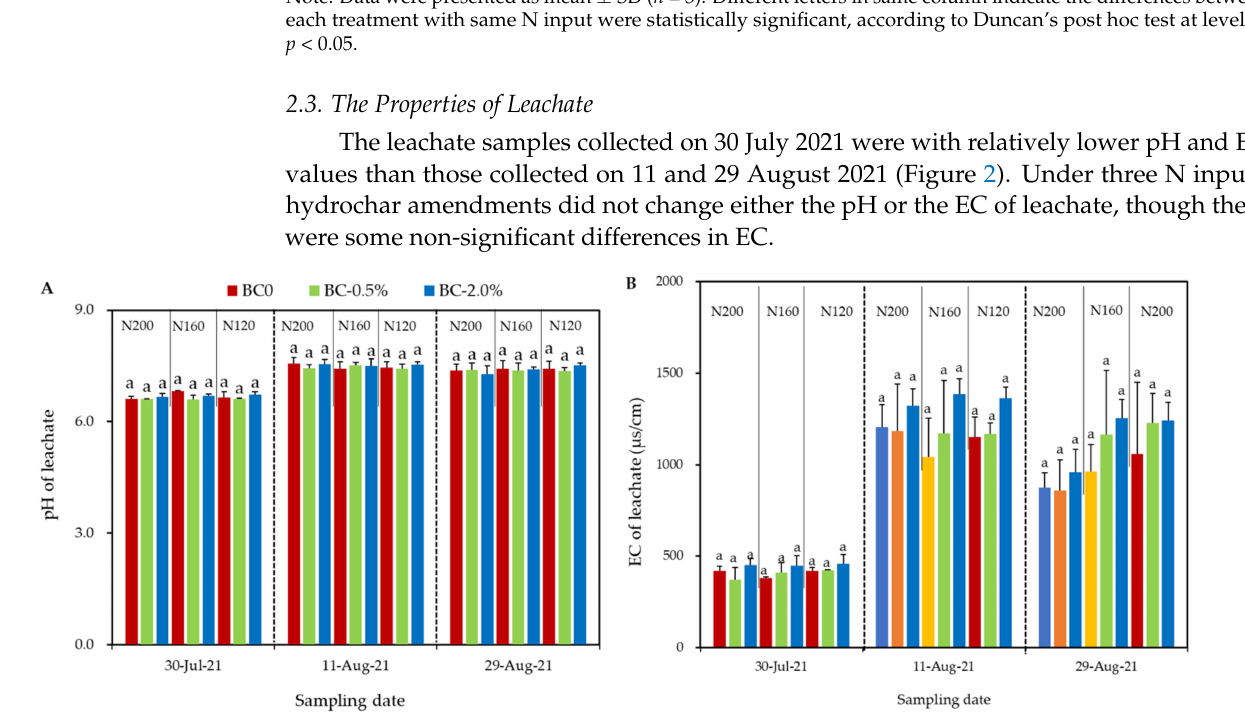
Figure 2. The pH ( A ) and EC ( B ) of leachate sampled at three observations on 30 July, 11 August, and 29 August 2021. Error bars represent the SD of the mean of three replicates. Same letters above column chart indicate the differences between each treatment with same N input were not statistically significant, according to Duncan’s post hoc test at level of p <